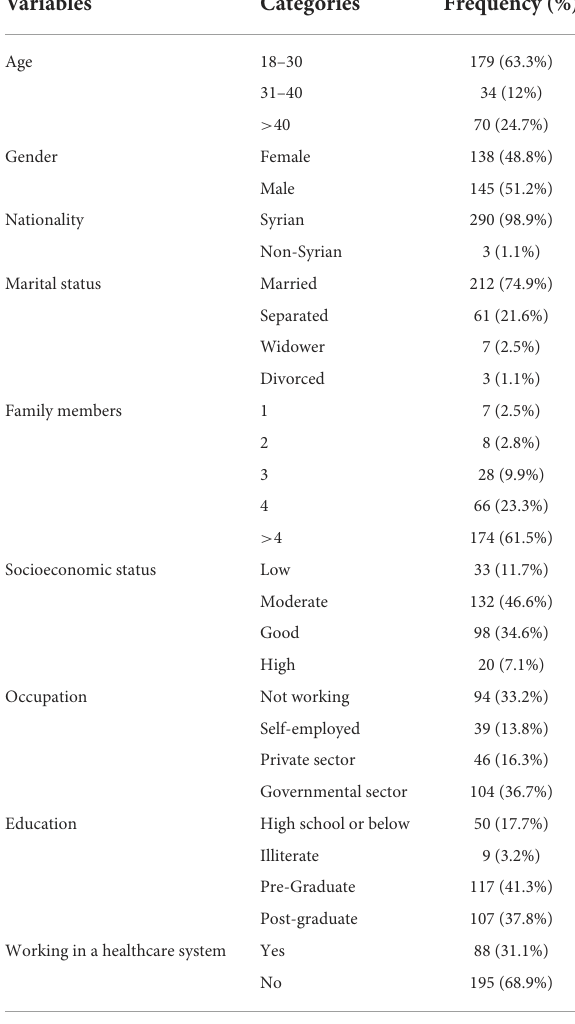
TABLE 1 Sociodemographic characteristics of the parents assessed for their willingness to vaccinate their children with a COVID-19 vaccine.